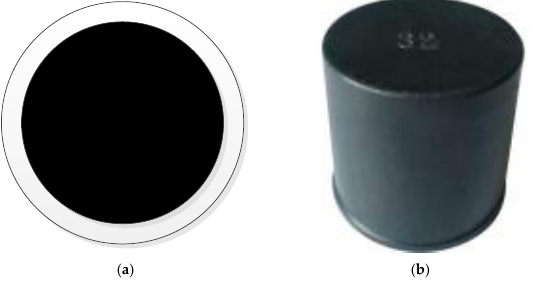
Figure 4. Shows the visual location markers. ( a ) Disc marker; ( b ) Cover marker.